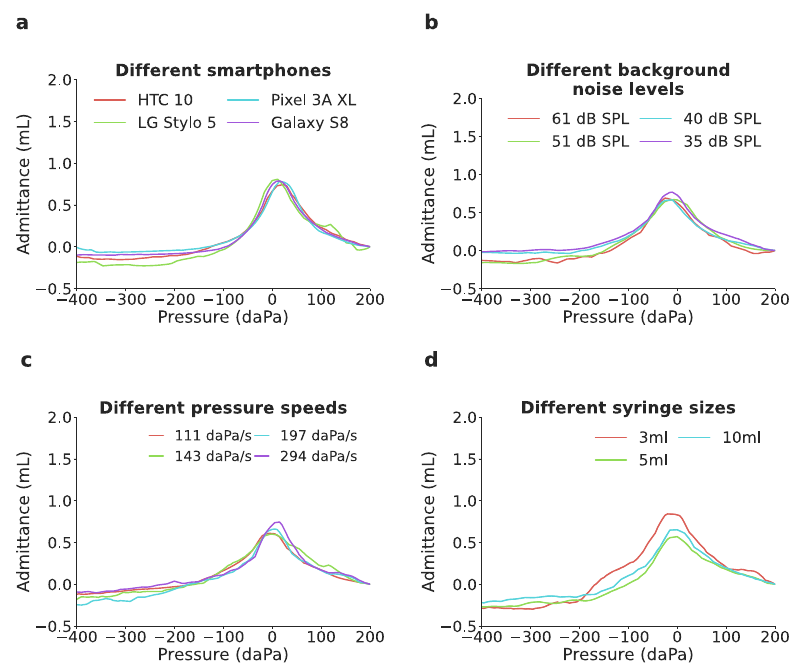
Fig. 6 Benchmark testing across different measurement scenarios and design parameters. The system was evaluated across a different smartphones including budget models, b different background noise levels c different pressure sweep speeds, d different syringe volumes. Source data are provided in Supplementary Data